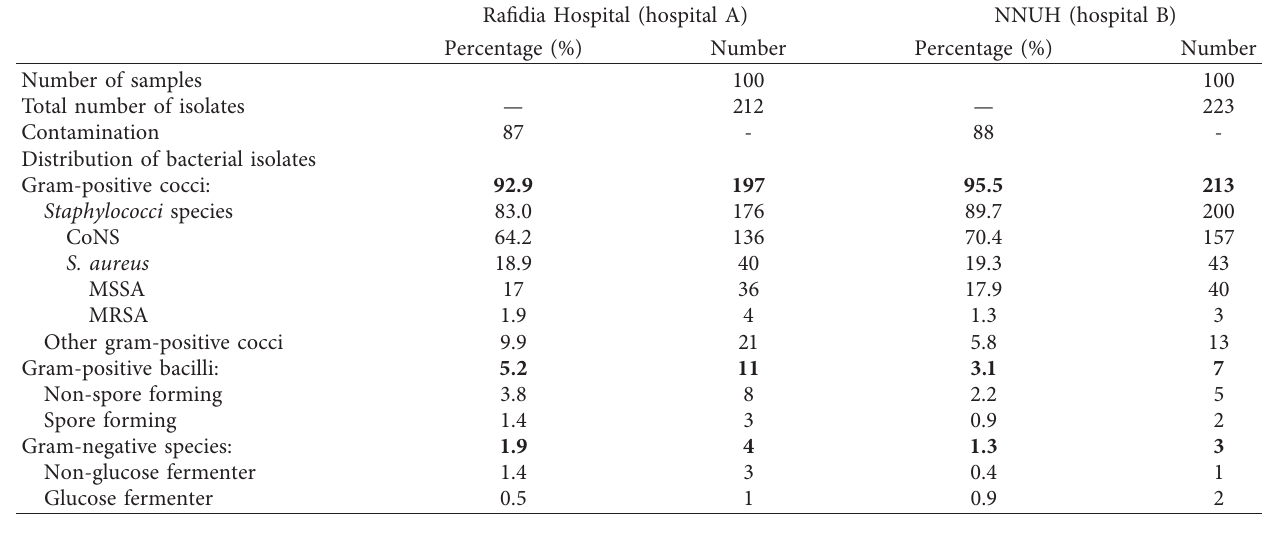
Table 3: Comparison of bacterial isolates between hospitals A and B.